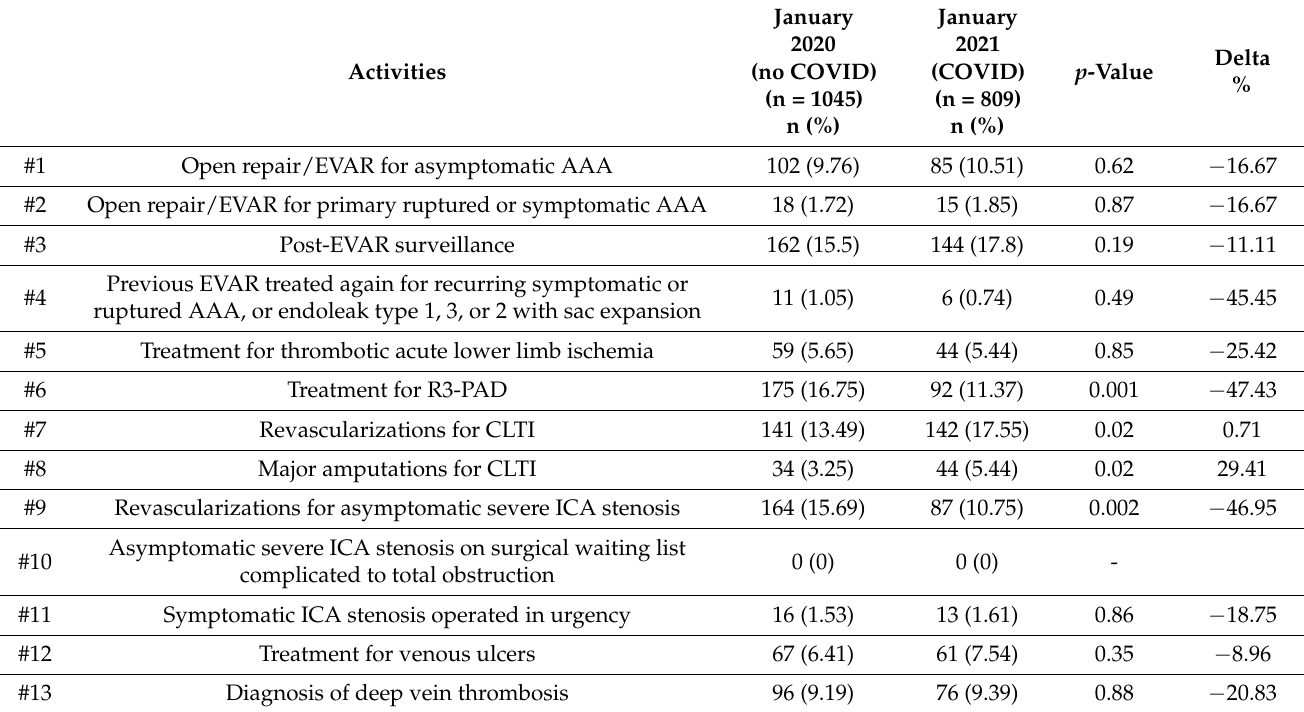
Table 2. Summary of the responses to the questionnaire for the COVID-19 period from April to Table 9. Summary of the responses to the questionnaire for the COVID-19 month of January 2021